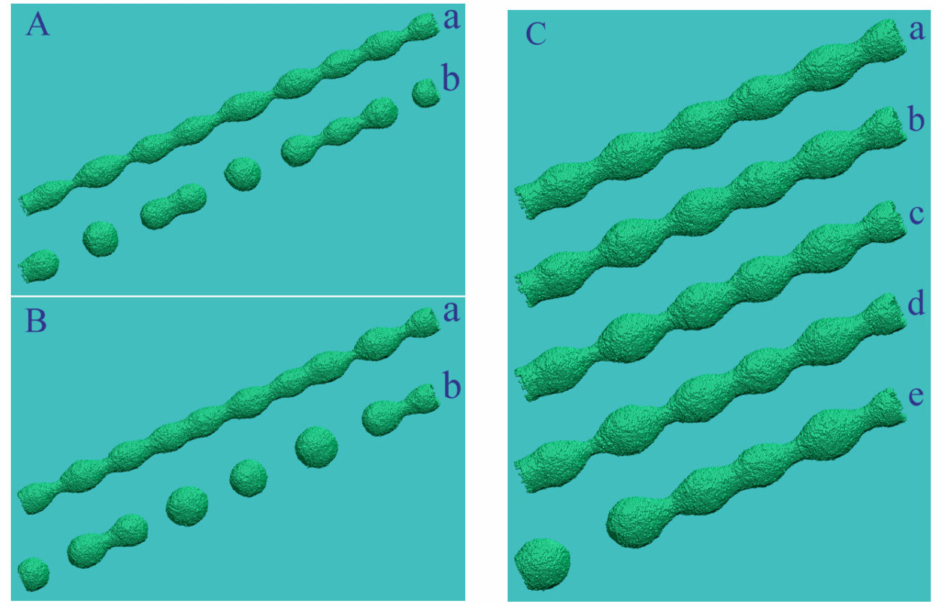
Figure 8. Shapes of nanowires with (110) orientation at different stages of transformation upon stimulation of surface diffusion of atoms: α = 1, p = 0.825: ( A ) r nw = 15.5, L = 700; for configurations (cid:0) × (cid:1) 10 6 (a,b) t = 1.50 and 3.54 MC steps; ( B ) r nw = 17.5, L = 700; (a,b) t = 2.70 and 5.88 steps. ( C ) r nw = 20.5, L = 500; (a–e) t = 2.25, 4.50, 6.75,8.40 and 15.0